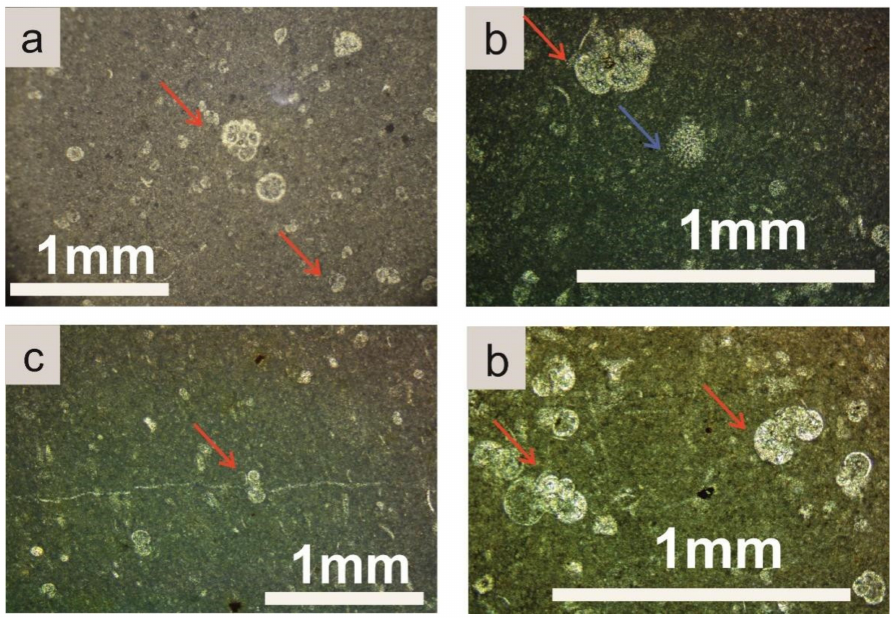
Figure 15. Microfacies typeF3: Mudstone/wackestone with planktic foraminifera of Eocene age. ( a ) planktic foraminifera (red arrow), sample KM1, ( b ) planktic foraminifera (red arrow), radiolaria (blue arrow), sample M20, ( c ) planktic foraminifera (red arrow), sample M4 ( d ) planktic foraminifera (red arrow), sample